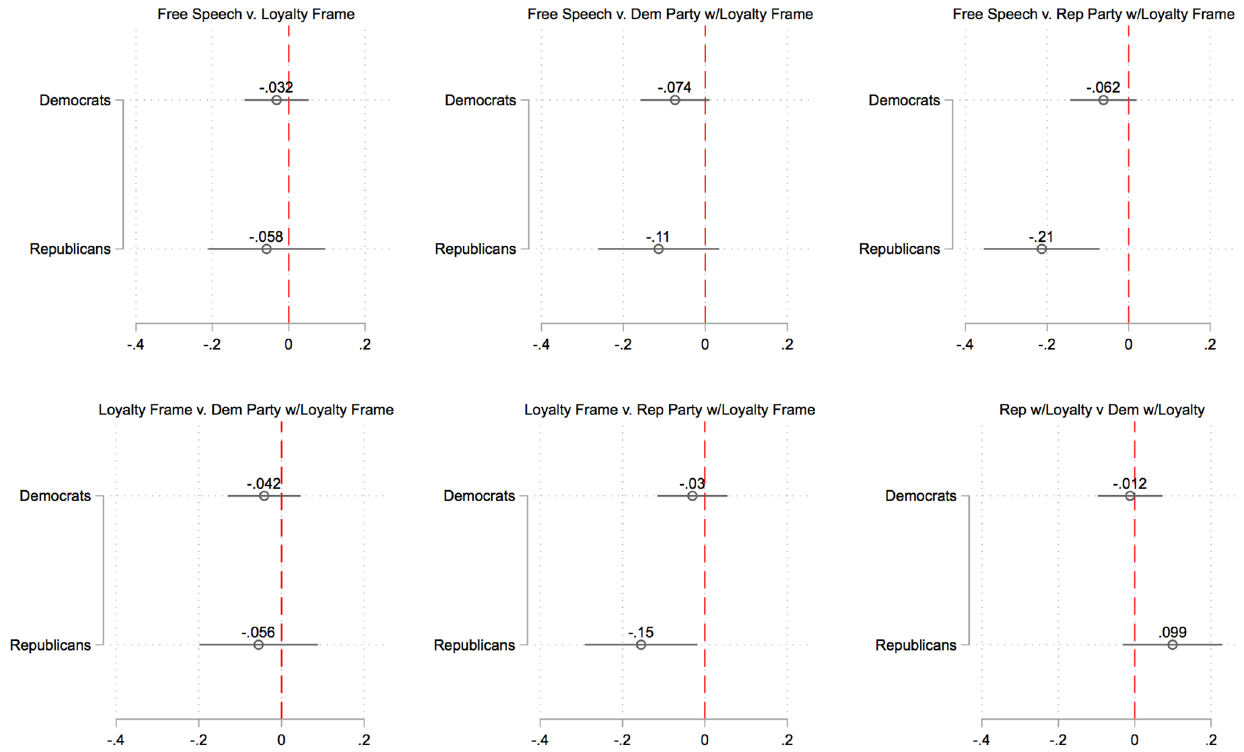
Figure 3. Experimental treatment effects on flag burning tolerance by party ID (Study 1). Note. Open dots represent the estimated marginal effects of the experimental treatment (the comparison described in each panel's title) for Democrats and Republicans, with lines representing 95% confidence intervals. The three panels in the top row present marginal effects generated from the OLS regression model without demographic controls provided in Table 1, Column 4. The left and middle panels in the bottom row present marginal effects generated from the OLS regression model without demographic controls provided in Table 1, Column 5. The right panel in the bottom row presents marginal effects generated from the OLS regression model without demographic controls provided in Table 1, Column